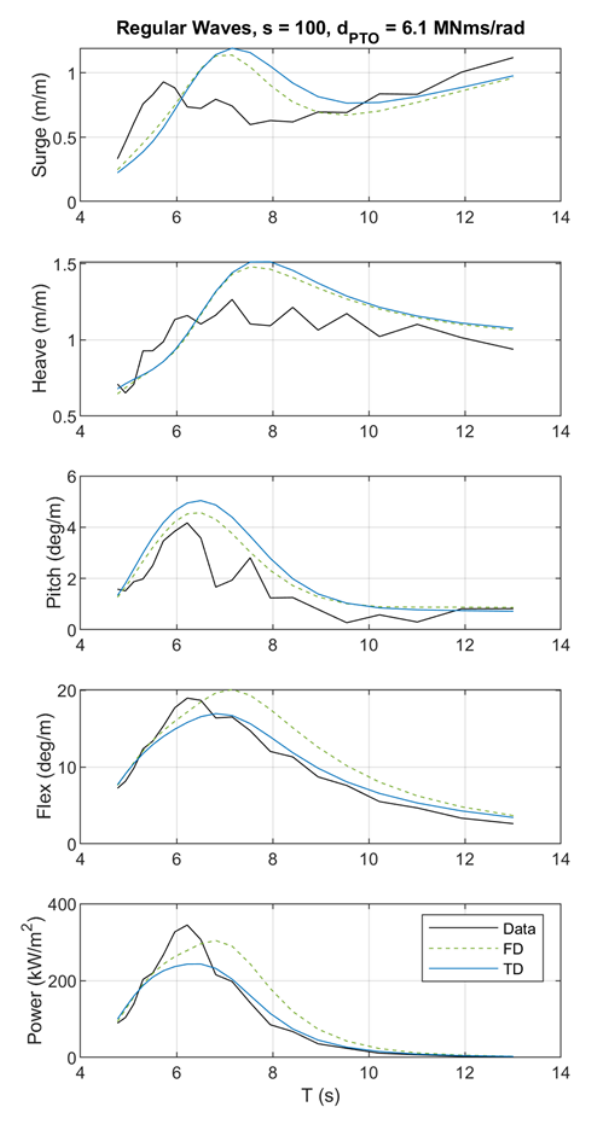
Fig. 8. RAO Test Set